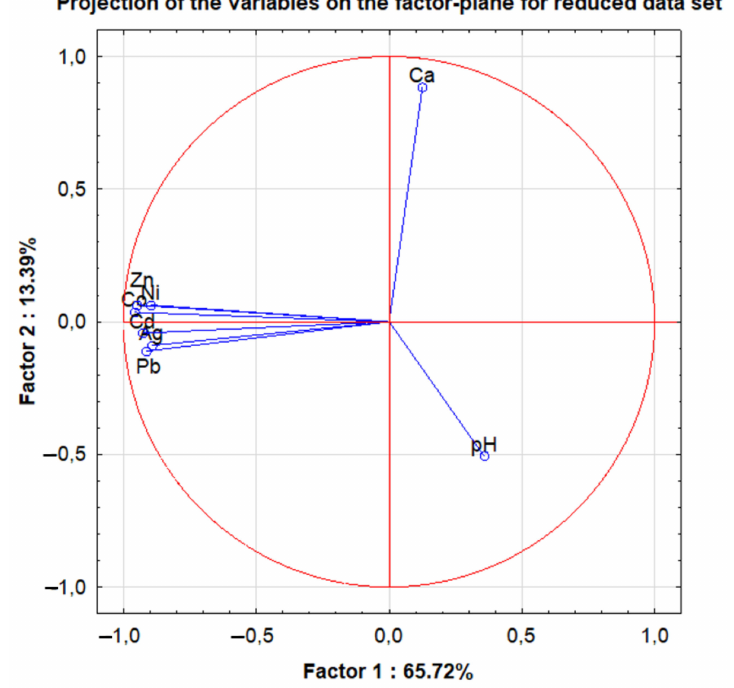
Figure 5. Projection of the variables on the factor-plane for reduced data